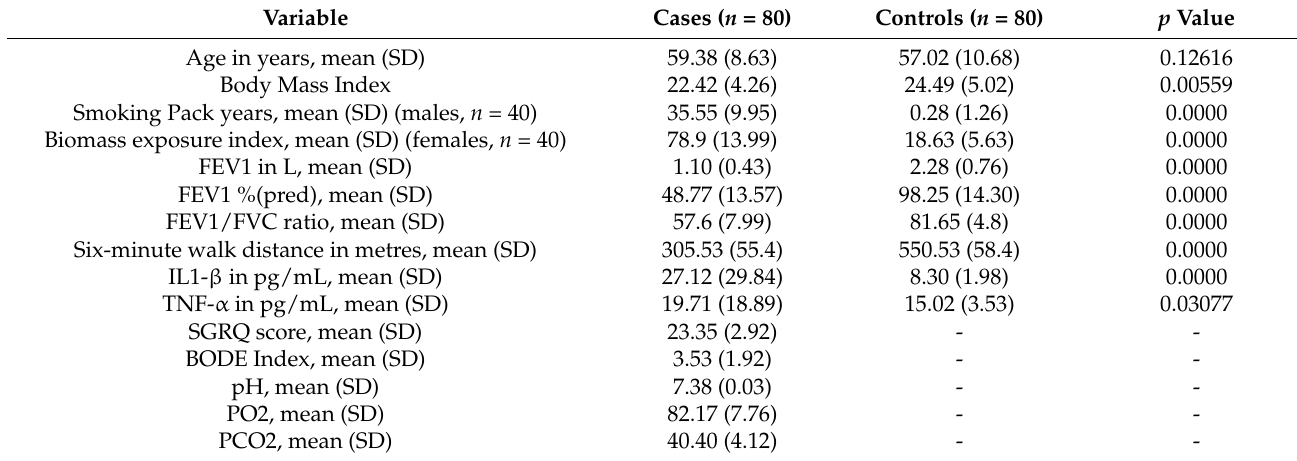
Table 1. Demographic and clinical details of COPD cases and controls in the study.